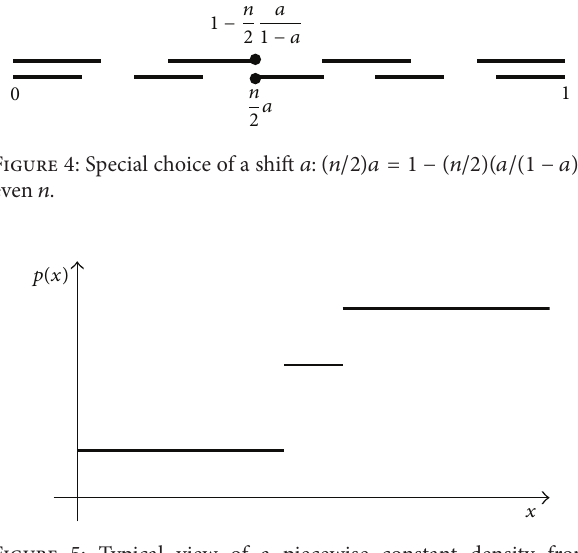
Figure 5: Typical view of a piecewise constant density from Theorem